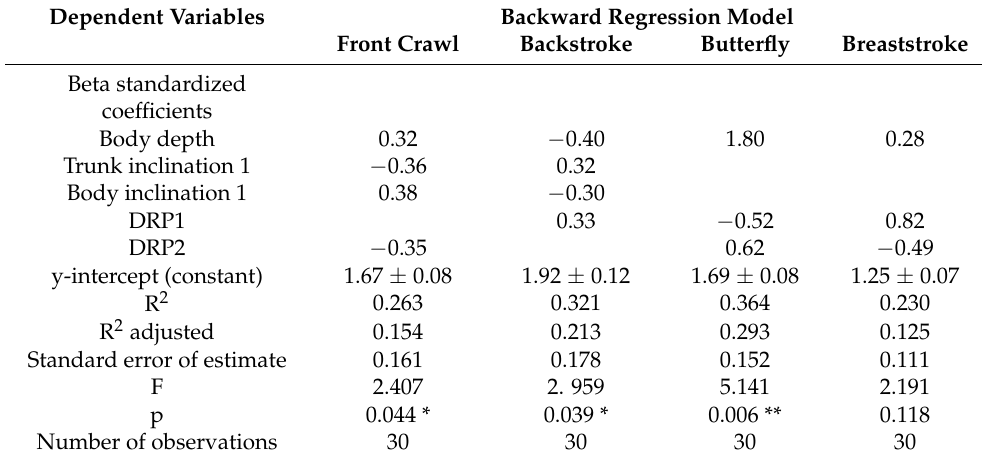
Table 2. Backward regression analysis of the transition phases in all four